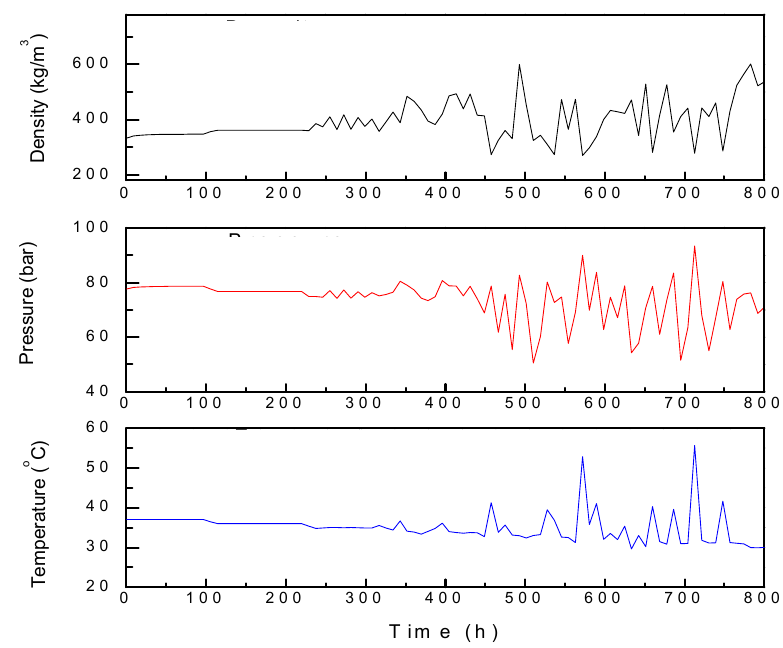
Figure 6. Simulation results of case 4 (reduction in heater temperature).